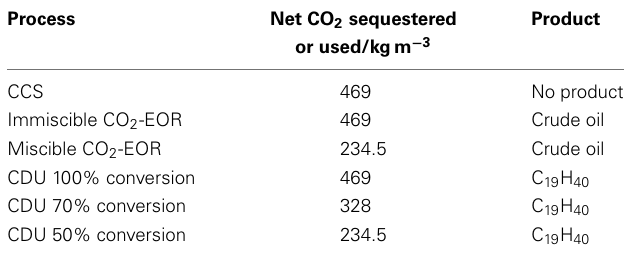
Table 3 | Net sequestration of CO 2 by the different mitigation technologies for “cradle to gate” analyses